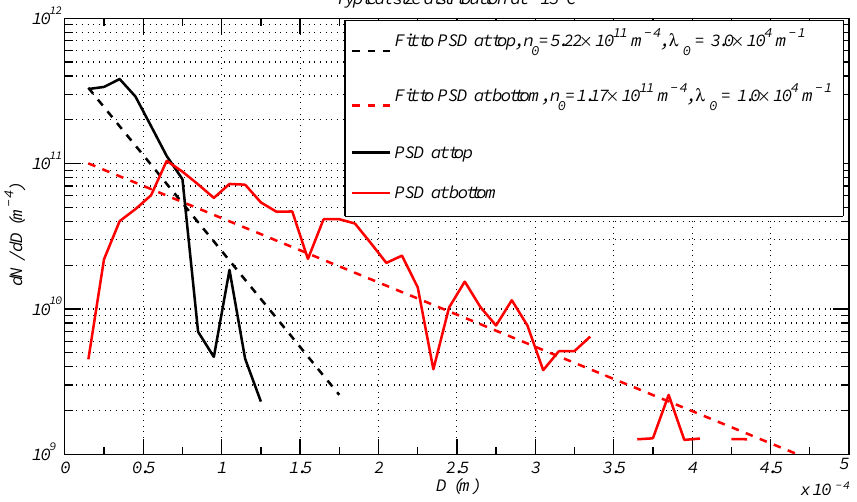
Fig. 9. An example of the ice crystal size distributions measured at the two levels in the chamber with best fits to exponential functions.